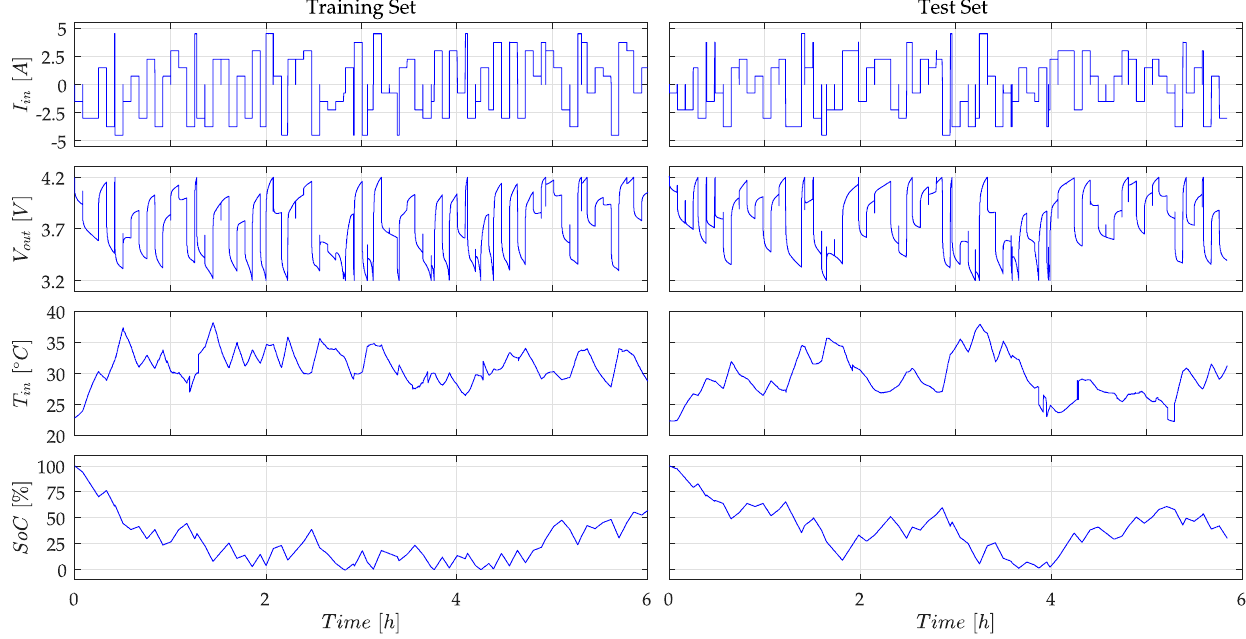
Figure 9. I in , V out , T in , and SoC time series referring to the Randomized Battery Usage-NASA dataset.